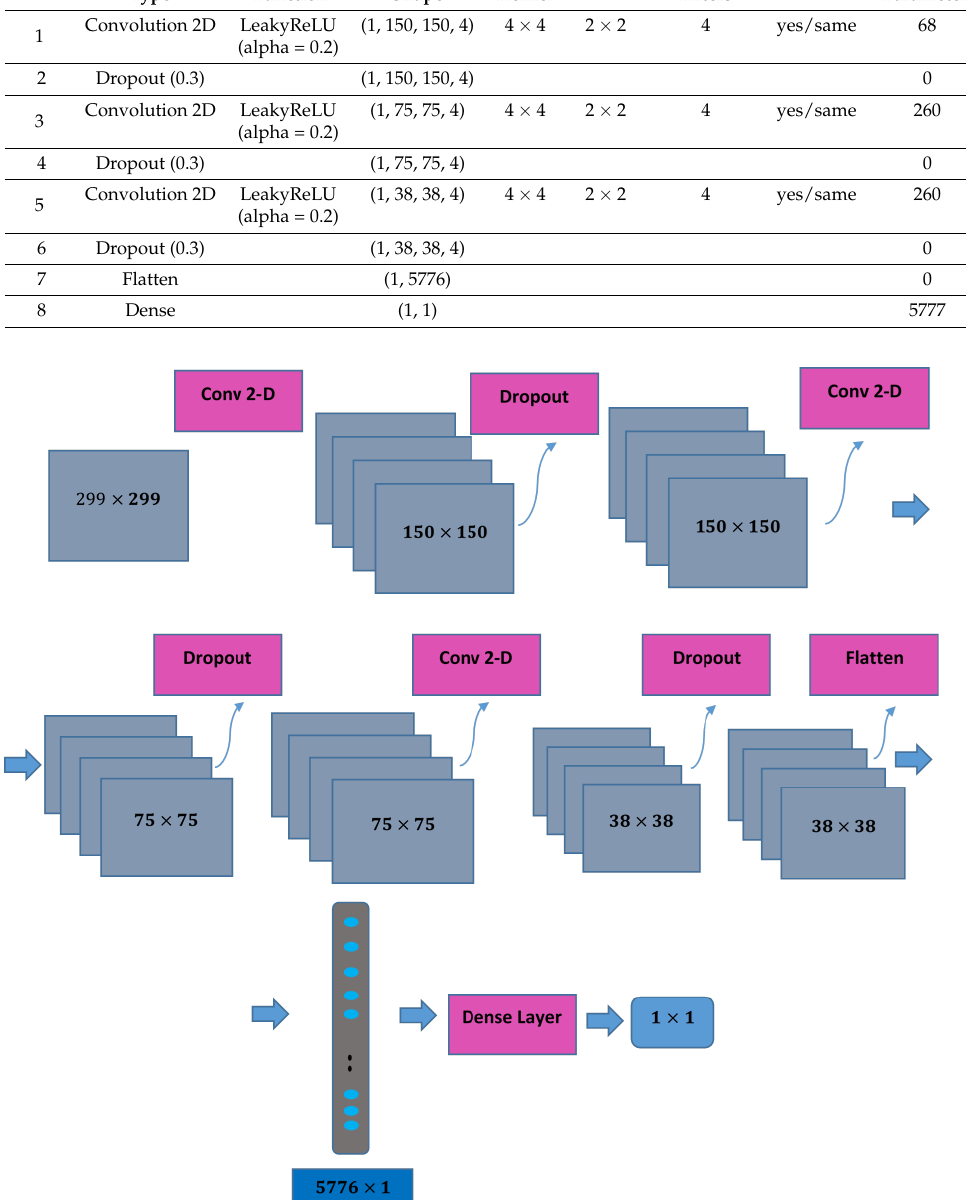
Figure 7. Dimensions of different layers of discriminator part of the proposed